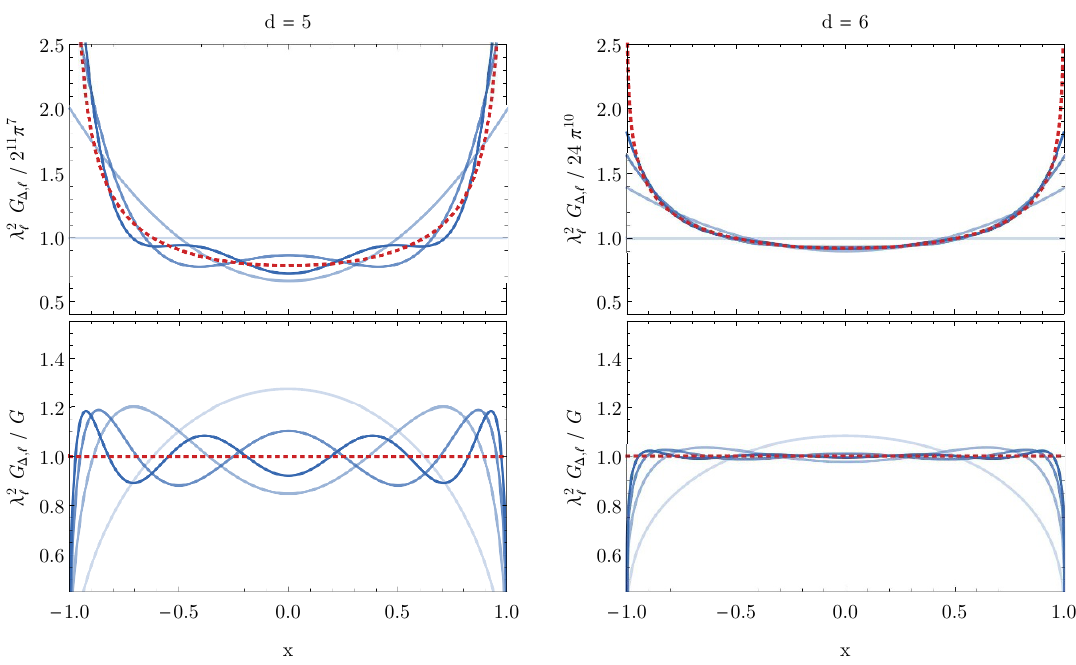
Figure 5 . The combined contribution of conformal blocks up to a maximal spin ℓ max = 0 , 2 , 4 , 6 (from lighter to darker blue lines) to the imaginary part of for the operator φ 2 in the free scalar M theory, in d = 5 (left) and d = 6 (right) spacetime dimensions. The red dotted line indicates the full result given in eq. (4.4). The upper panels correspond to the actual value of the conformal blocks, while the lower panels show their relative